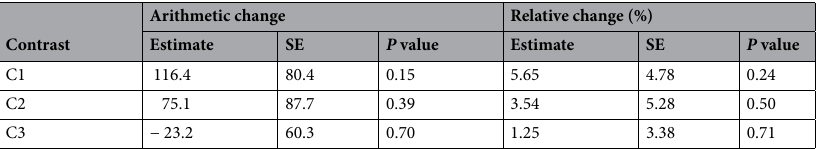
Table 3. Mean hourly activity data shown for the different analysis contrasts, presented as either arithmetic or percentage change from baseline. Estimate = change from baseline in mean hourly activity counts with robenacoxib relative to placebo. Estimate = change from baseline in hourly activity counts with robenacoxib relative to placebo. C1 contrast 1 = treatment group PP compared against groups RR and RP following 3 weeks of treatment, C2 contrast 2 = treatment group PP compared against group RR following 6 weeks of treatment, C3 contrast 3 = treatment group RP compared against RR for change in activity between weeks 3 and 6 of treatment, SE standard error, P placebo, R robenacoxib. * P values test whether the contrast is significantly different from zero.